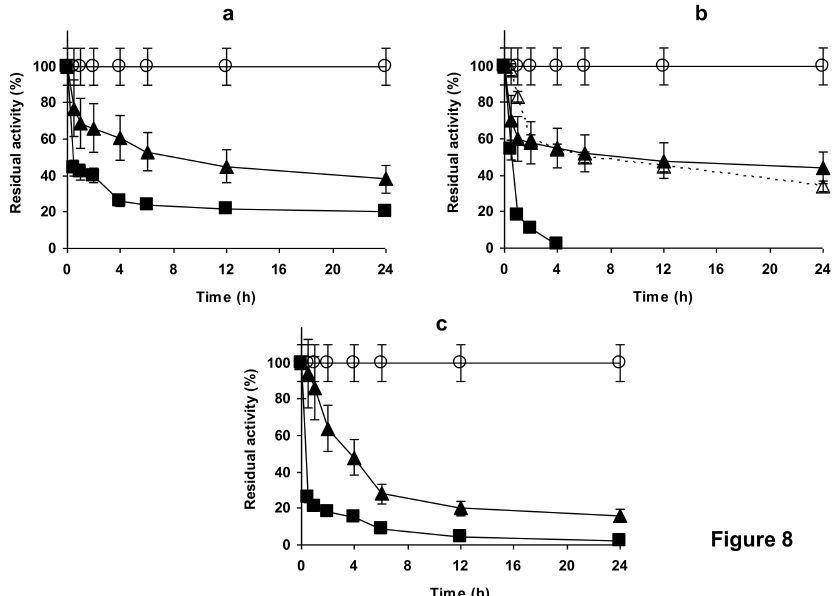
Figure 8. Immobilization of ficin extract on MANAE-agarose beads activated with glutaraldehyde. Experiments were performed as described in the Section 3 using 25 mM of buffer, at pH 5 ( a ), 7 ( b ) or 9 ( c ). Open circles, solid lines: reference; Using BANA as substrate (solid lines, solid symbols): Triangles: suspension, Squares: supernatant. Using casein as substrate (only at pH 7): dotted line, empty